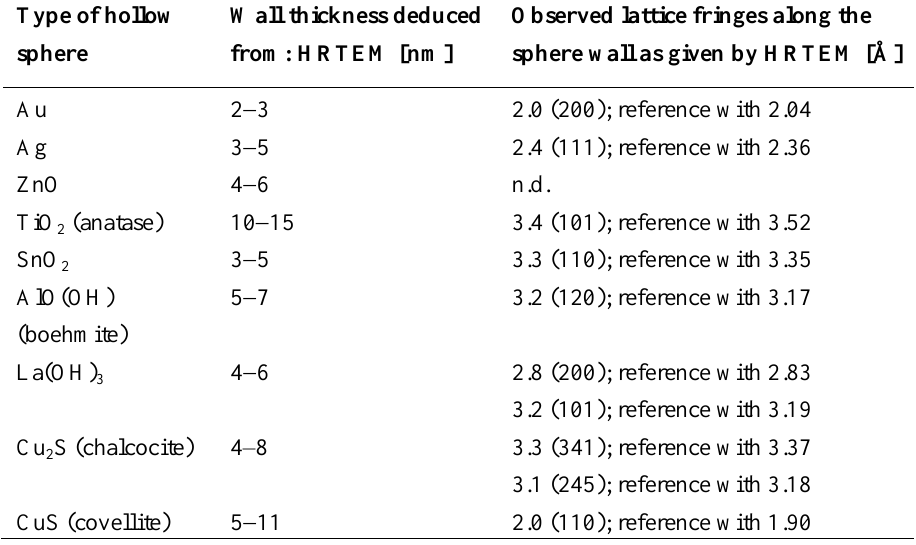
Table 3. Wall thickness and chemical composition as deduced from the observed lattice fringes of various hollow spheres as made via the microemulsion